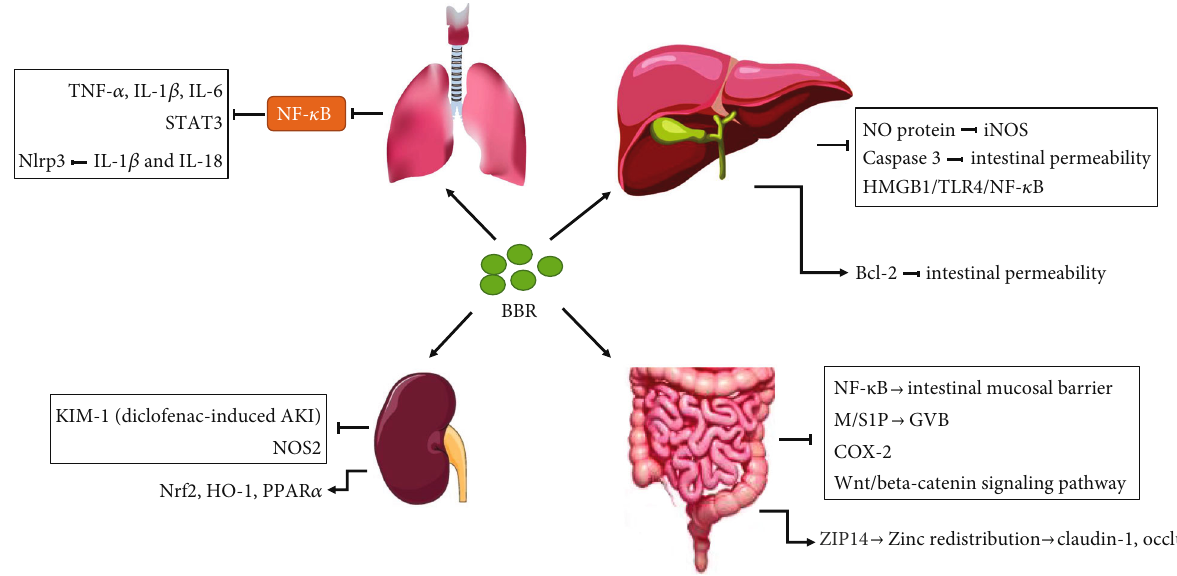
Figure 1: The protective e ff ect and mechanism of berberine for sepsis-related organ